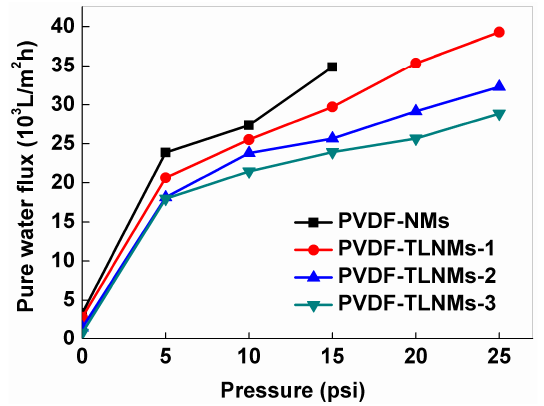
Figure 6. The pure water flux of PVDF ‐ NMs, PVDF ‐ TLNMs ‐ 1 (0.05 mol ∙ L − 1 ), PVDF ‐ TLNMs ‐ 2 (0.10 mol ∙ L − 1 ) and PVDF ‐ TLNMs ‐ 3 (0.15 mol ∙ L − 1 ).